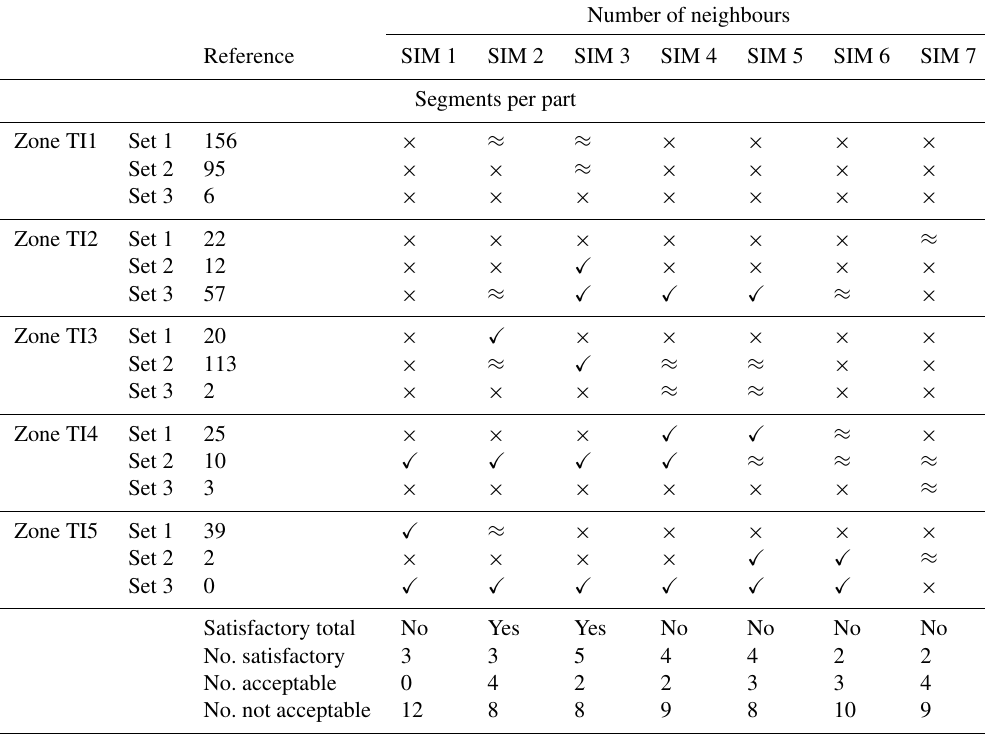
Table 4. Results of the sensitivity analysis on the influence of the number of neighbours. The table presents the number of segments per simulation zone for AP3 (used as a reference). × show a total number of segments of the considered set in the considered zone deviating by more than 20% from the reference case. ≈ show a deviation of more than 10% from the reference case. (cid:88) do not deviate significantly from the reference outcrop